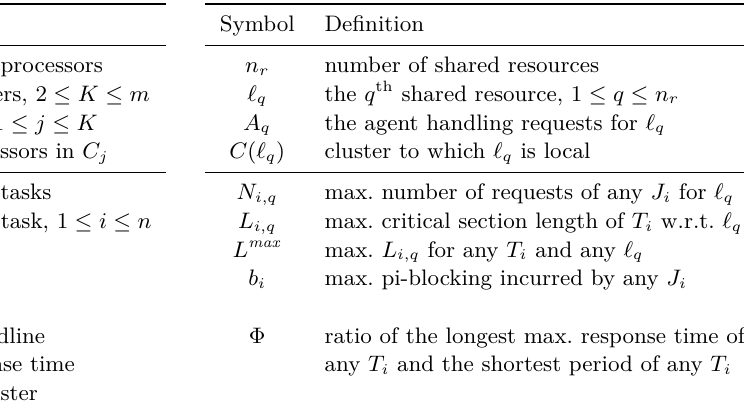
Table 1 Summary of